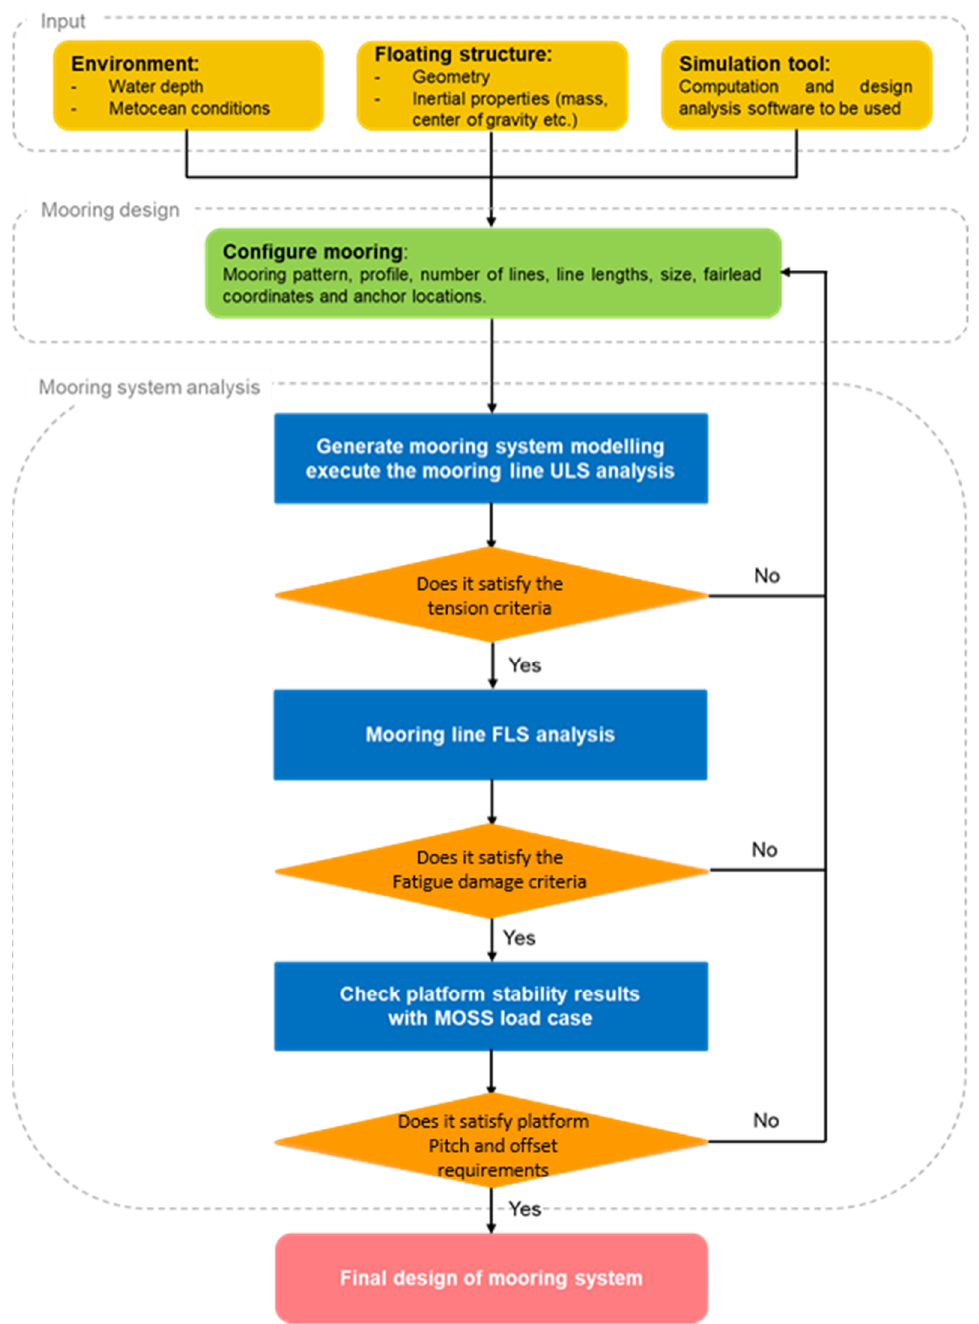
Figure 7. Mooring design procedure of FOWT [6].